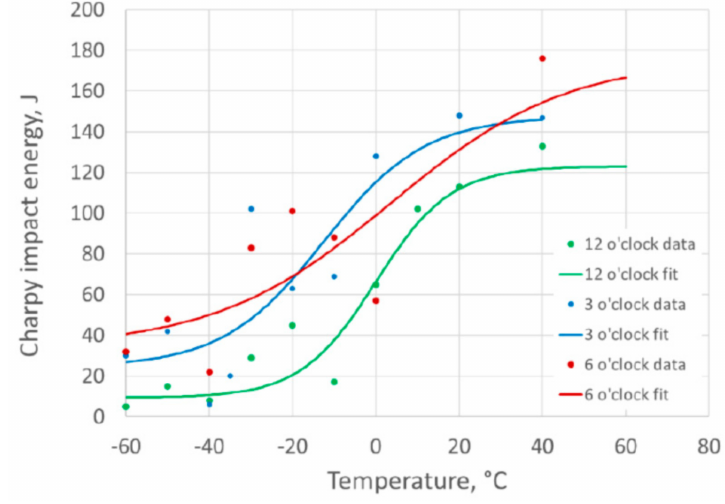
Figure 7. Charpy impact energy ductile-to-brittle transition curves for weld centerline notched specimens.